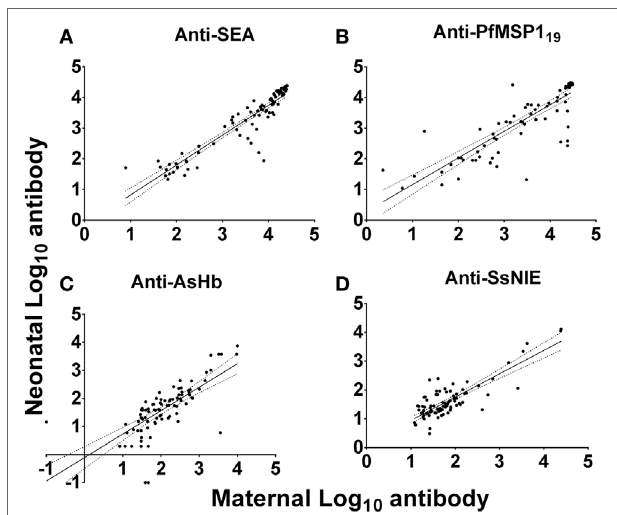
FigUre 3 | Correlation of antibody levels of mothers and their neonates to parasite antigens soluble egg antigen (SEA) (a) , PfMSP1 19 (B) , Ascaris suum hemoglobin (AsHb) (c) , and SsNIE (D) . The solid line represents the regression trend line, flanked by dotted lines representing the 95% confidence interval (anti-SEA, r = 0.94; anti-PfMSP1 19 , r = 0.89; anti-AsHb, r = 0.80; anti-SsNIE, r = 0.65). All correlations were significant ( p < 0.0001).